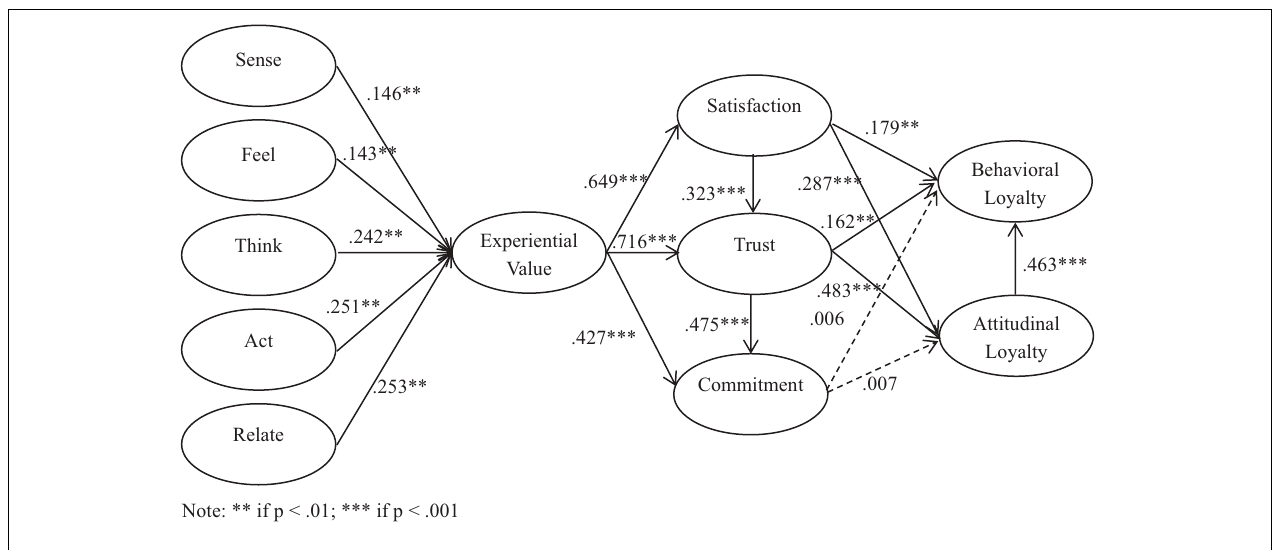
FIGURE 2 | Path coefficient of structural model. ∗∗ p < 0.01; ∗∗∗ p <